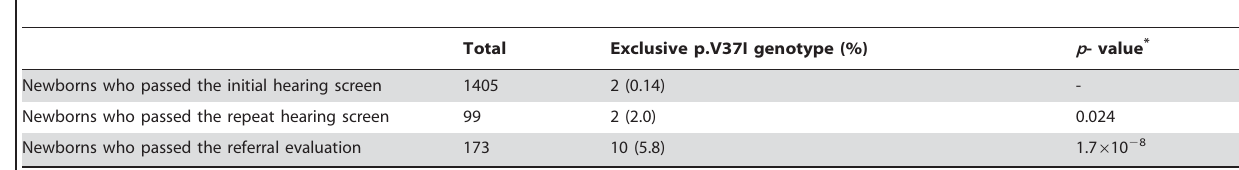
Table 3. Prevalence of the p.V37I exclusive genotype in normal hearing newborns with different NHS